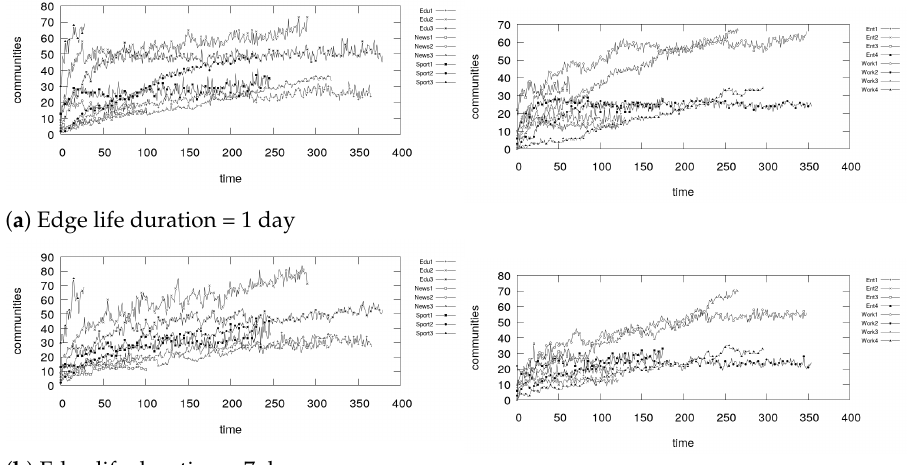
Figure 3. Number of communities detected by Fast Greedy.